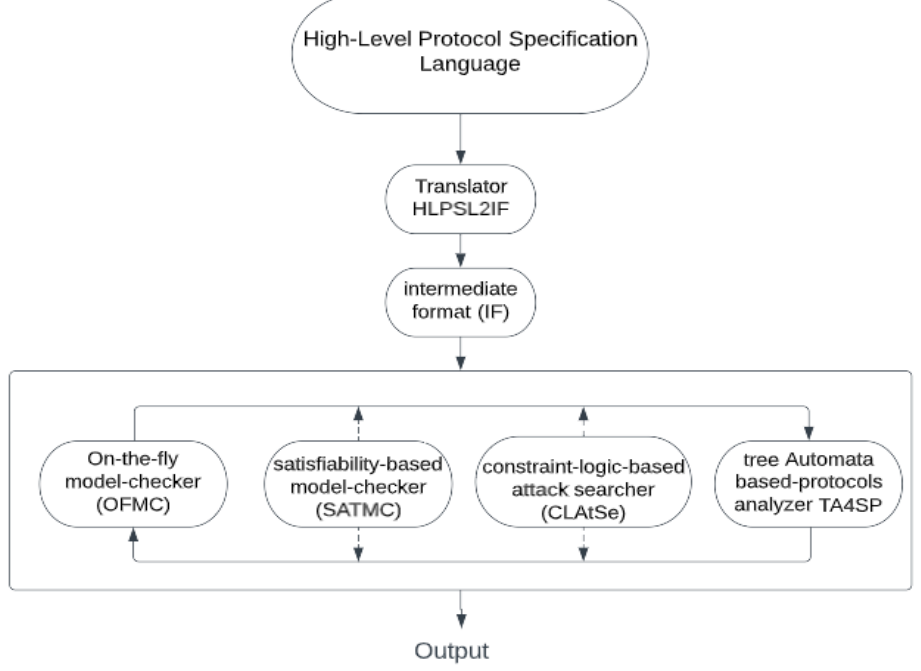
Figure 8. The AVISPA simulation tool architecture.